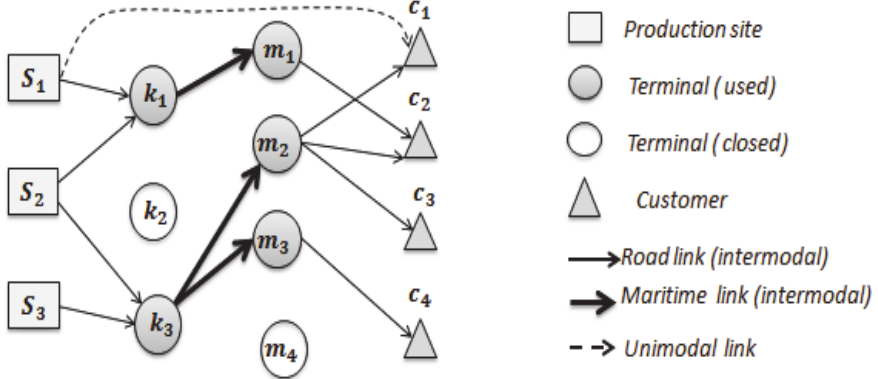
Fig. 2. Example of an intermodal transport network